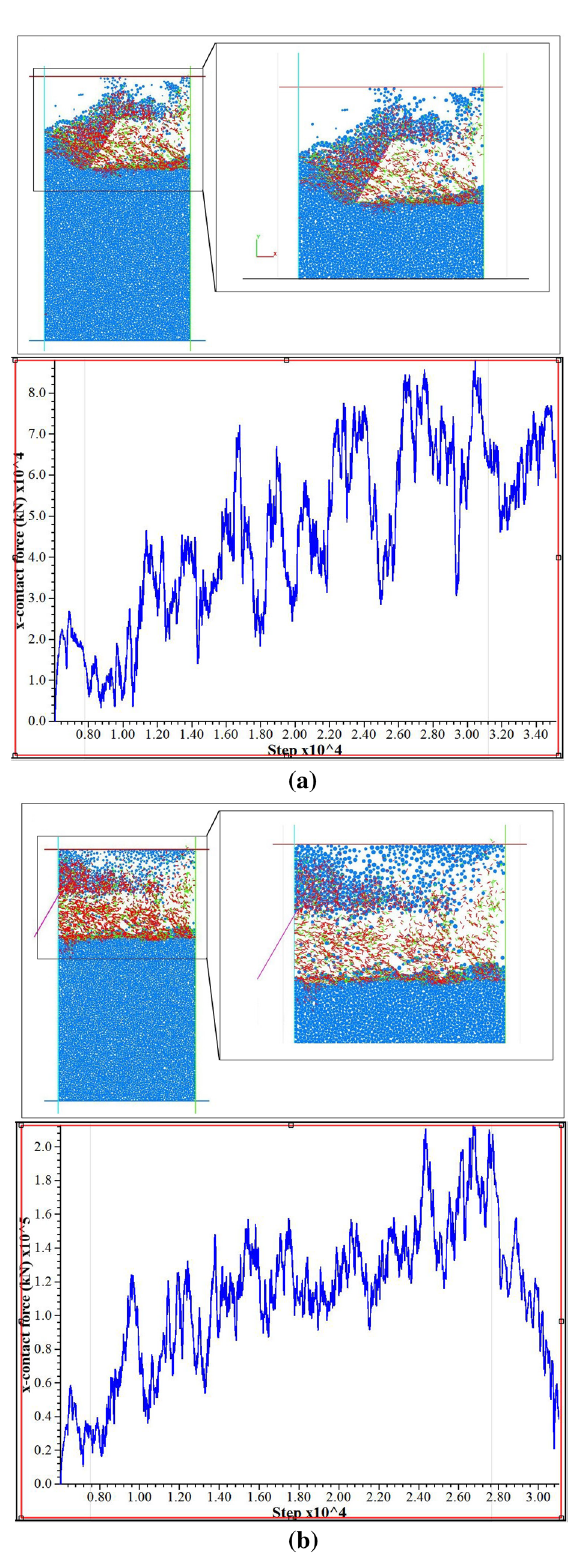
Fig. 15 Results of plow model with zero-degree angle: a Model 17, b Model 18